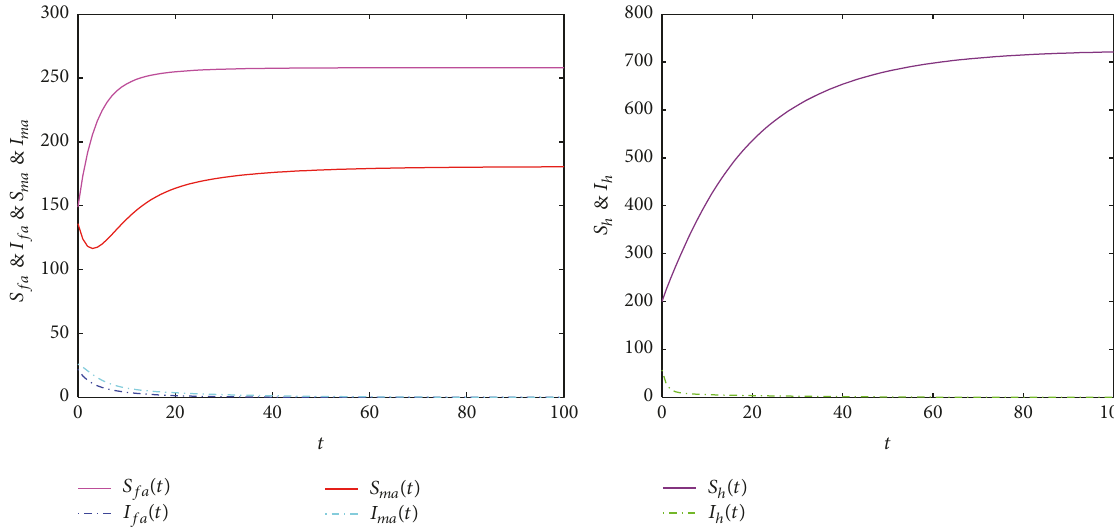
Figure 2: If 𝑅 0 = 0.88680353 < 1 , the time-variation diagram of system (25) state variables is shown.